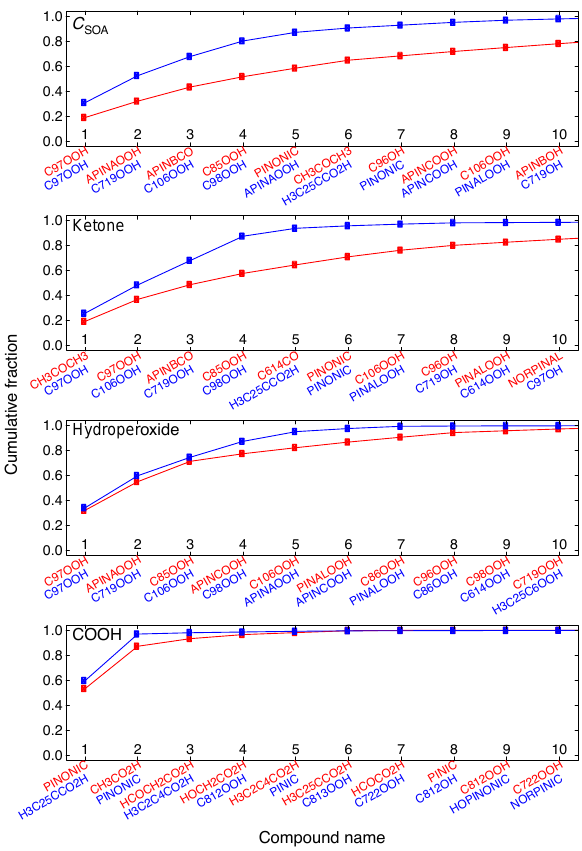
Figure 7. Cumulative contribution (as a fraction of total) of each compound to the overall C SOA mass and abundance of different FGs for the APIN-nNO x simulation. Compounds are arranged in order of decreasing contribution (i.e., the first compound contributes most) for each phase. Contributions to the aerosol phase are shown in blue and the gas phase in